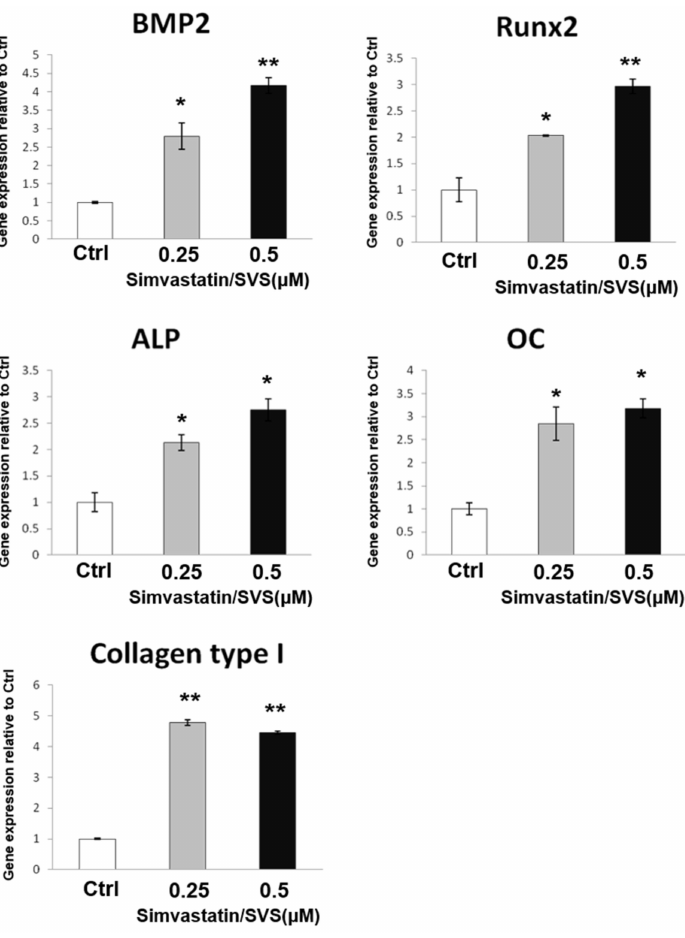
Figure 1. Simvastatin (SVS) increases mRNA expression levels of osteogenic markers in D1 cells. D1 cells (passage 8) were treated with SVS at concentrations of 0 (control: Ctrl), 0.25, and 0.5 µ M in basal medium for 3 days. Total RNA was isolated and subjected to real-time PCR analysis. The mRNA expression levels of osteogenic marker genes (bone morphogenetic protein-2 (BMP-2), runt-related transcription factor 2 (Runx2,) alkaline phosphatase (ALP), osteocalcin (OC), and collagen type I) were detected after 3 days of SVS treatment. The gene expression levels are expressed relative to the Ctrl, which is defined as 1. The values presented are the mean ± SD ( n = 3). * p < 0.05 and ** p < 0.01 in comparison to the